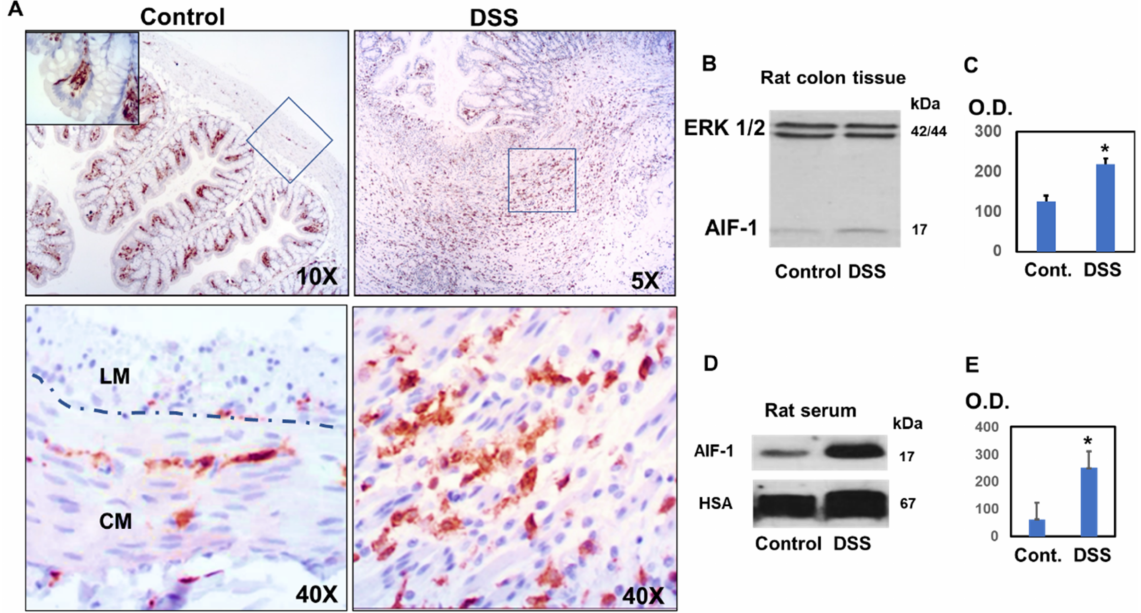
Figure 2. Study of the levels of AIF-1 in the colon and in the serum of rats with colitis induced by DSS for 5 days. ( A ) Localization of AIF-1 by immunohistochemical techniques in the colon of rats treated with DSS. The region indicated by the square has been enlarged in the figure below. ( B ) Analysis of AIF-1 levels in the colon by immunoblot. ERK has been studied as a load control. ( C ) Densitometric analysis of AIF-1 levels in the colon obtained by immunoblot. Mean ± SEM. ( D ) Study of AIF-1 levels in serum by immunoblot. Human serum albumin (HSA) has been tested as a loading control. ( E ) Densitometric analysis of AIF-1 levels in the serum obtained by immunoblot. Mean ± SEM. The images are representative of at least 5 others with similar results. LM = longitudinal muscle